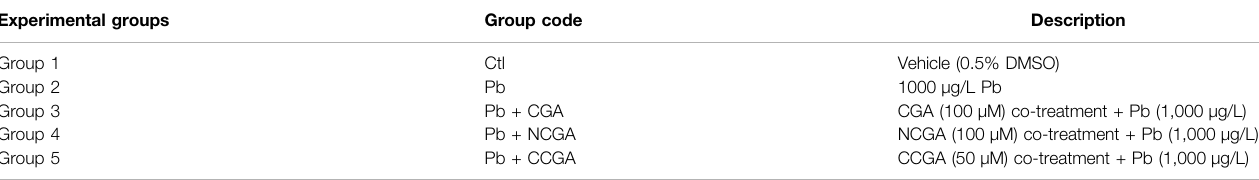
TABLE 1 | Experimental groups evaluating the protective effect of CGA, CCGA, and NGA against Pb-induced neurodevelopmental toxicity in zebra fi sh. Experimental